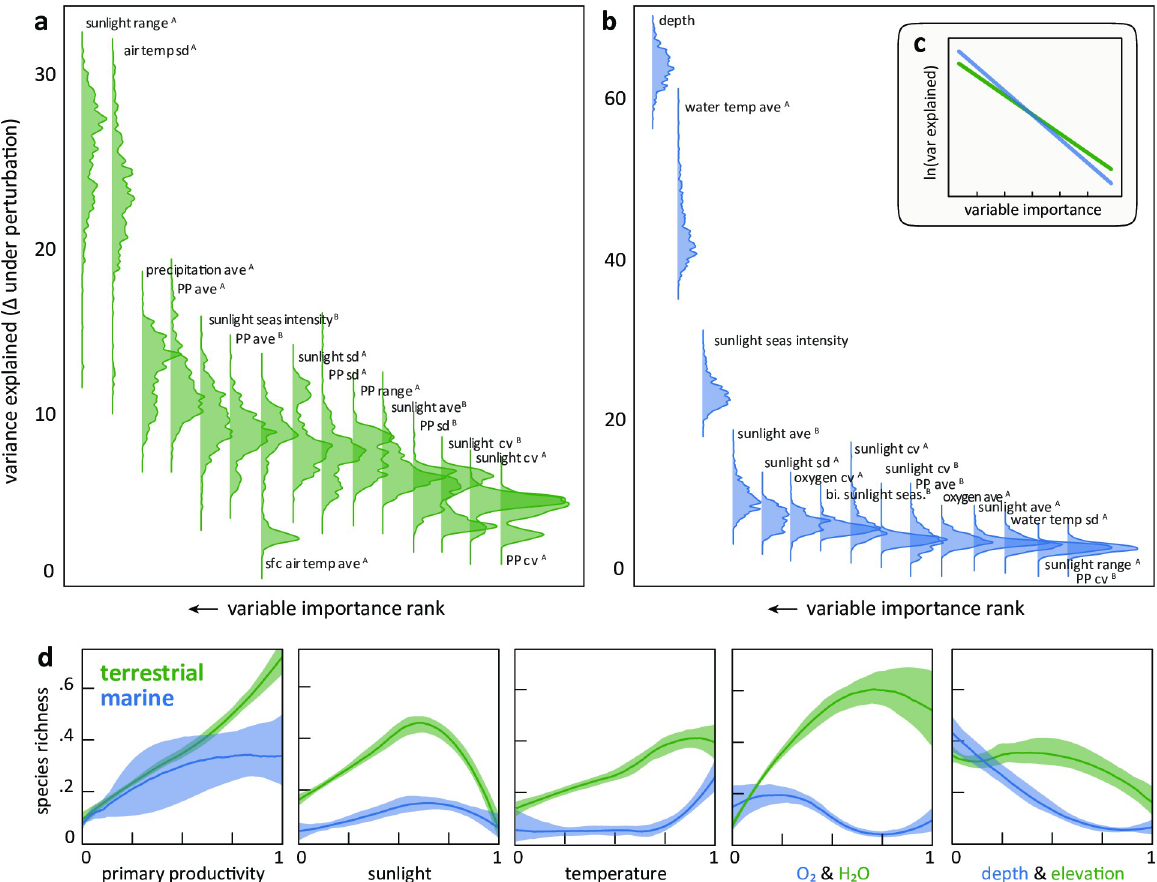
Fig 2. Environmental drivers of species richness in marine and terrestrial domains. The ranked importance of the top 15 environmental variables in the (a) terrestrial and (b) marine ANNs. Bootstrapped driver variable importance plots display the densities of change in explained variance made when perturbing individual model factors. The process is repeated 500 times with a random subset of the data on which a new ANN model is trained, generating a robust importance ranking by allowing multiple weight matrices to be evaluated as to how they learn the driver-richness relationship. On the variable labels, “A” is measured within year, “B” is between years. (c) Inset plot shows these same relationships on a log-linear scale, highlighting the steeper decline of variable importance and therefore greater effect of fewer variables in marine systems. (d) Pairwise plots showing the effects from a subset of individual drivers on species richness. To alleviate overplotting, graphs display the median ensemble (with 95% quantiles) of 100 local regression models fit from resamples of the global dataset. For (d) all variables are annual means and rescaled to 0–1 without further transformation. Similar factors are plotted when the same do not exist in both domains. Supporting information provide the full list of all modelled variables and their